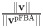
Norm of v vs. growth rate.The histogram shows that the growth rate achieved by the adaptation process is proportional to the ratio ∣∣v∣∣∣∣vpFBA∣∣ at the time of absorption. “Short” v cannot give maximal growth.